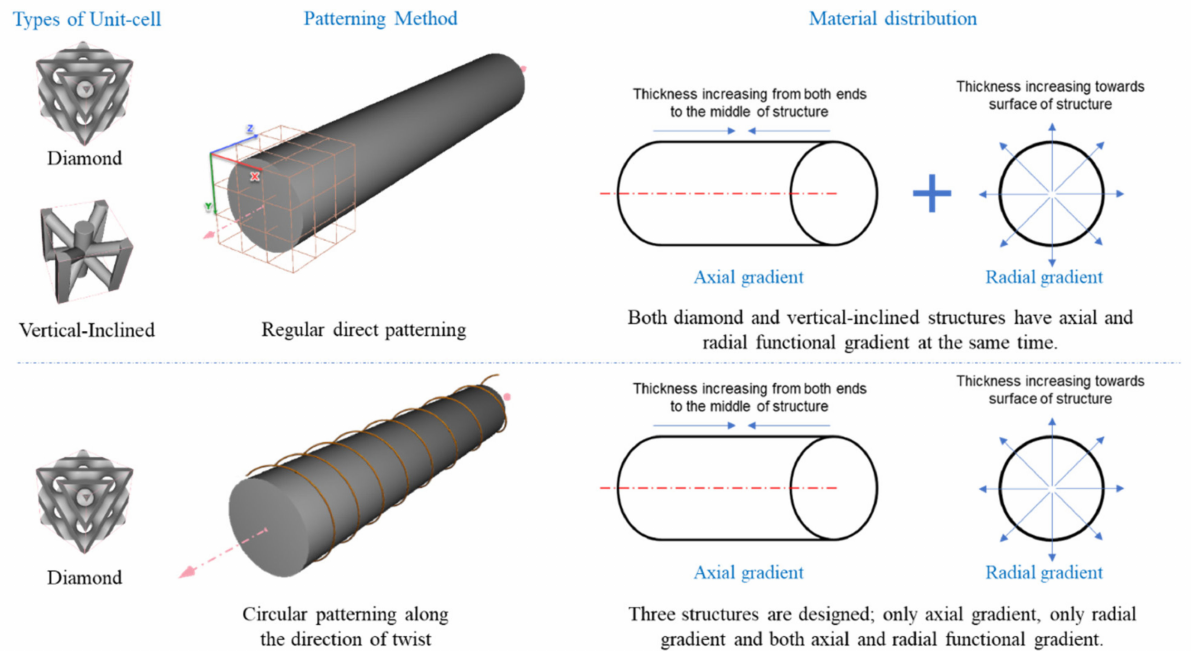
Figure 1. Schematics of functional gradient structures having regular and circular